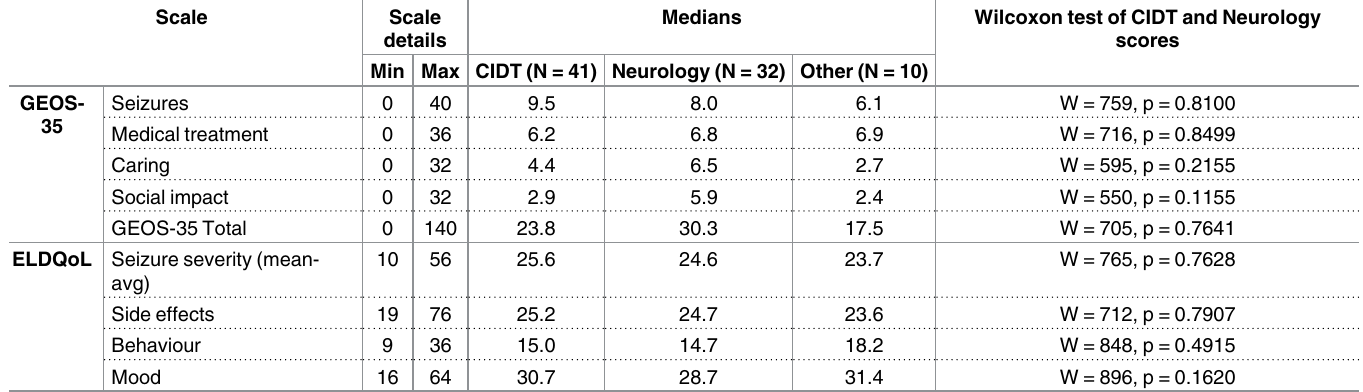
Table 4. The profile of outcome scalesvariables within each of the clinical servicesand the Other group. GEOS-35 = GlasgowEpilepsy Outcome Scales-35. ELDQoL = Epilepsy and LearningDisabilitiesQuality of Life. CIDT = CommunityIntellectual DisabilityTeam.